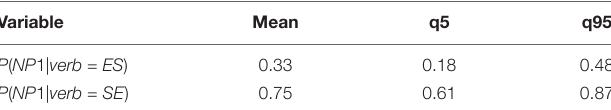
TABLE 13 | Value of P ( NP 1) across verb type for the Expectancy model, Experiment